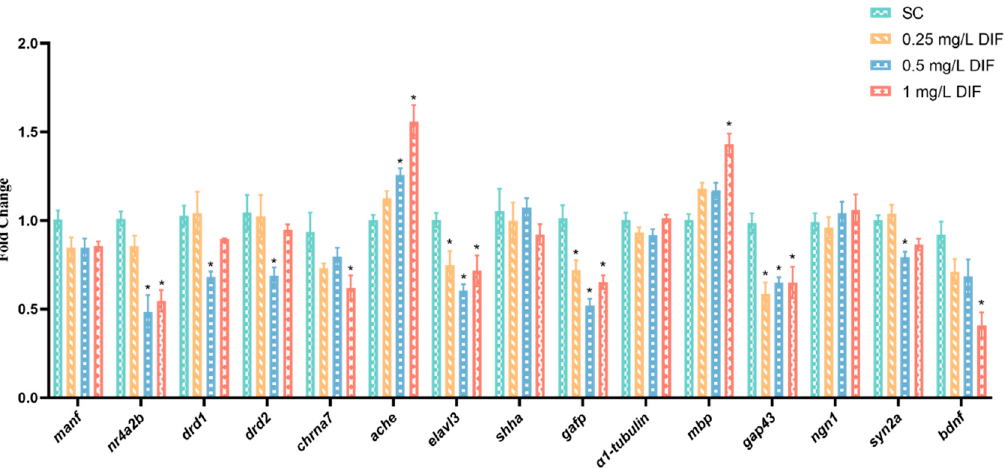
Figure 7. Gene transcription analysis of zebrafish after exposure to difenoconazole for 120 h (mean ± SEM, n = 3 replicates). * p < 0.05 indicates significant differences between exposure groups and the control